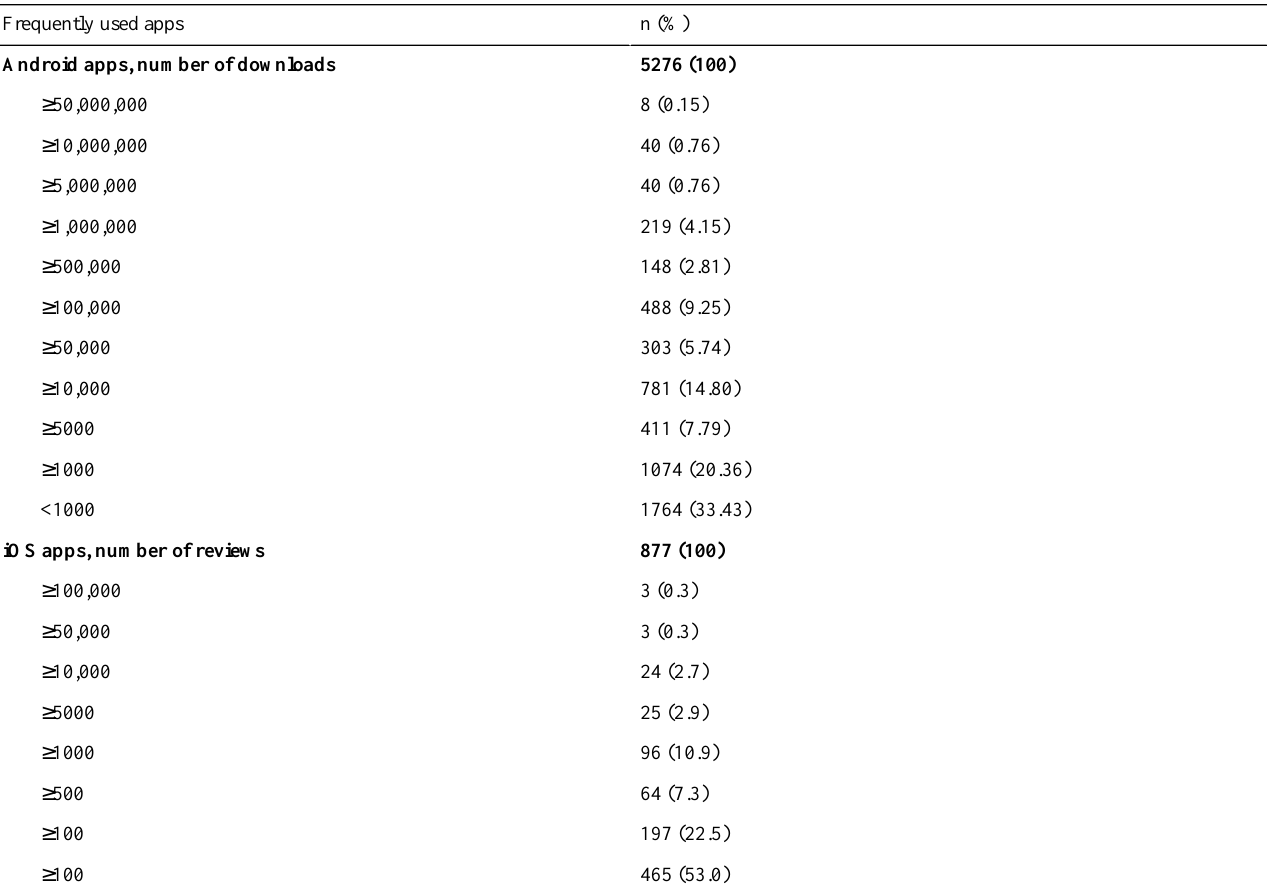
Table 1. Distribution of maternal and child health care apps with different number of downloads or reviews.